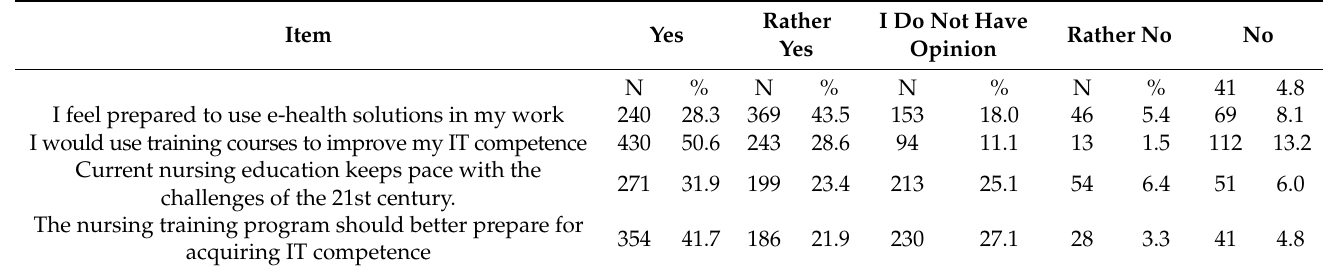
Table 3. Nurses’ opinion on IT competence and the education in this